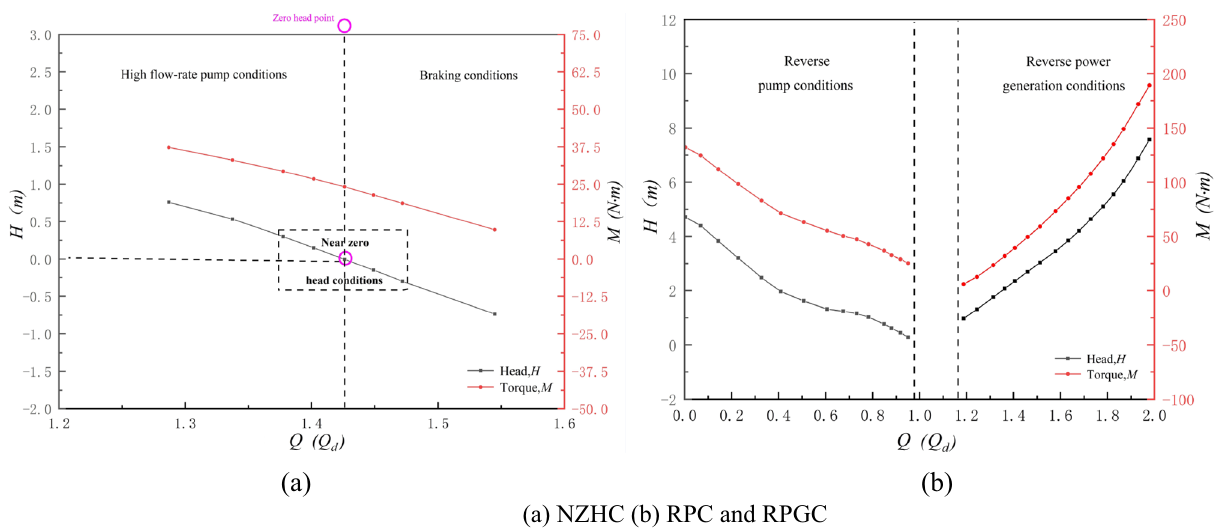
Figure 8. Local amplification diagram of the energy characteristic curve of the axial flow pump system under three special utilization